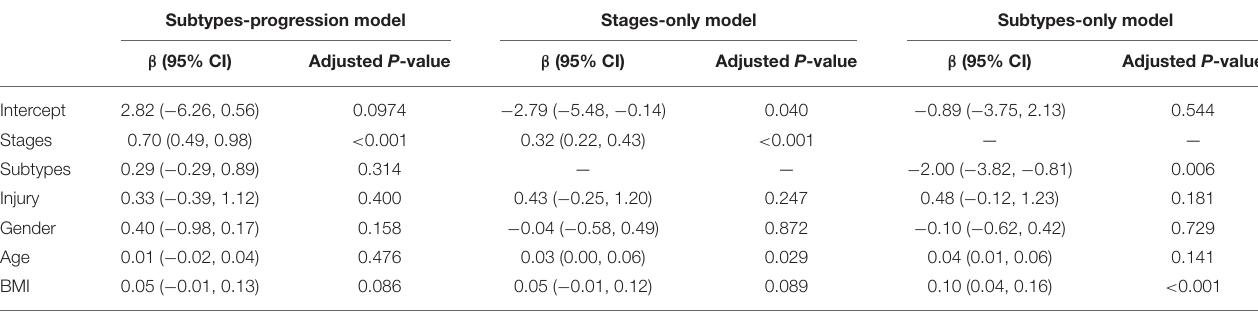
TABLE 3 | Results for comparing the subtypes and stages from subtypes-progression model with those from subtypes-only and stages-only with logistic regression model by separating knees with no or doubtful KOA (KL grade 0/1) from those with KOA (KL grade ≥ 2). Subtypes-progression model Stages-only